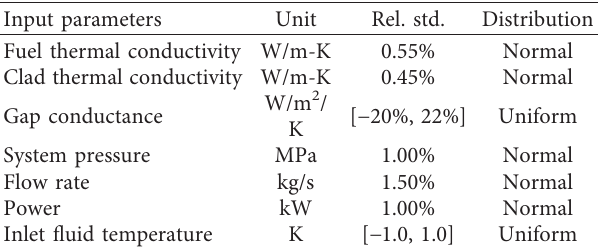
18: TMI-1 assembly power at EOC and relative errors against benchmark Table 3: Input uncertainty of the couple multiphysics cycle de- pletion calculation.